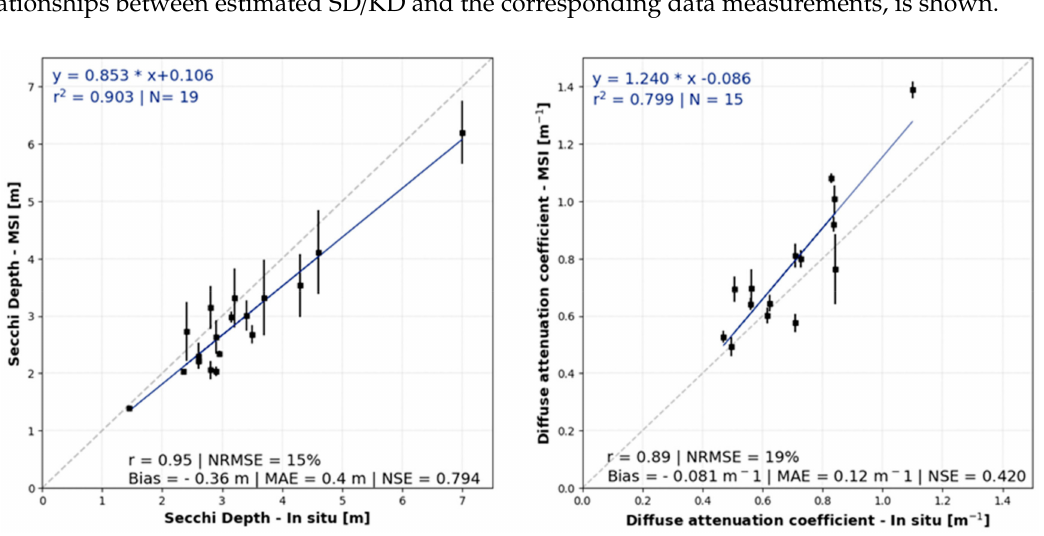
Figure 5. Scatter plot of predicted versus observed SD (left) and KD (right). The dashed line indicates the y = x, and solid line (blue) show the best-fit lines. The vertical error bars represent the standard deviations corresponding to the four selected